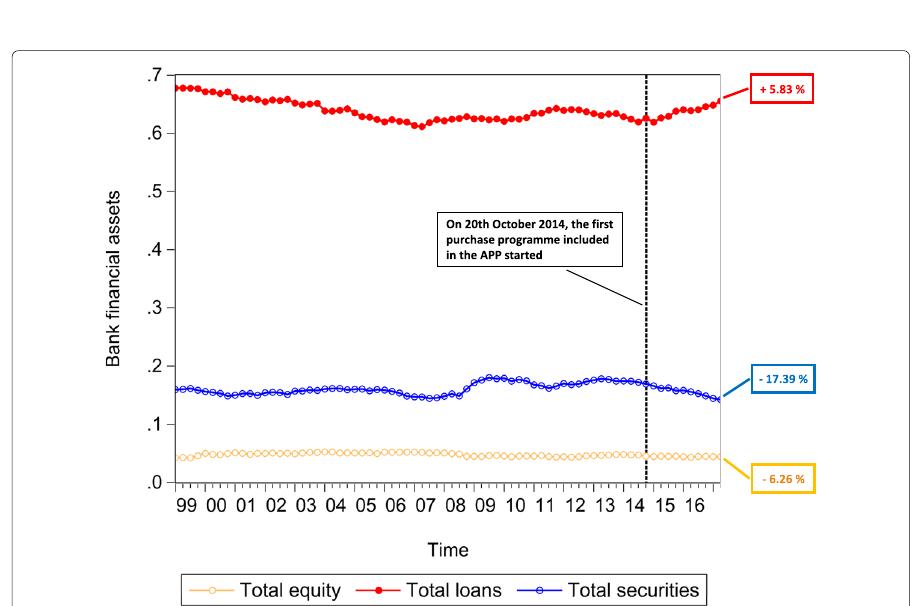
Fig. 11 Bank financial assets - breakdown by financial instrument; 1999Q1-2017Q2. Time series of the breakdown of the financial assets held by Monetary Financial Institutions excluding the Eurosystem by financial instrument, i.e., short-term and long-term loans and deposits (in red), short-term and long-term private and public debt securities (in blue), and listed, unlisted, and investment fund shares and other equity (in yellow), over the reference period 1999Q1-2017Q2. The aforementioned time series are normalized by Monetary Financial Institutions excluding the Eurosystem total financial assets. The vertical dashed line corresponds to the beginning of the first purchase programme (3rd Covered Bond Purchase Programme, CBPP3) included in the APP, started in 2014Q4, while the percentages on the right-hand side of the graph correspond to our estimate of the growth rates of the bank holdings of the three categories of financial instruments, since the initiation of QE. Data source: (European Central Bank